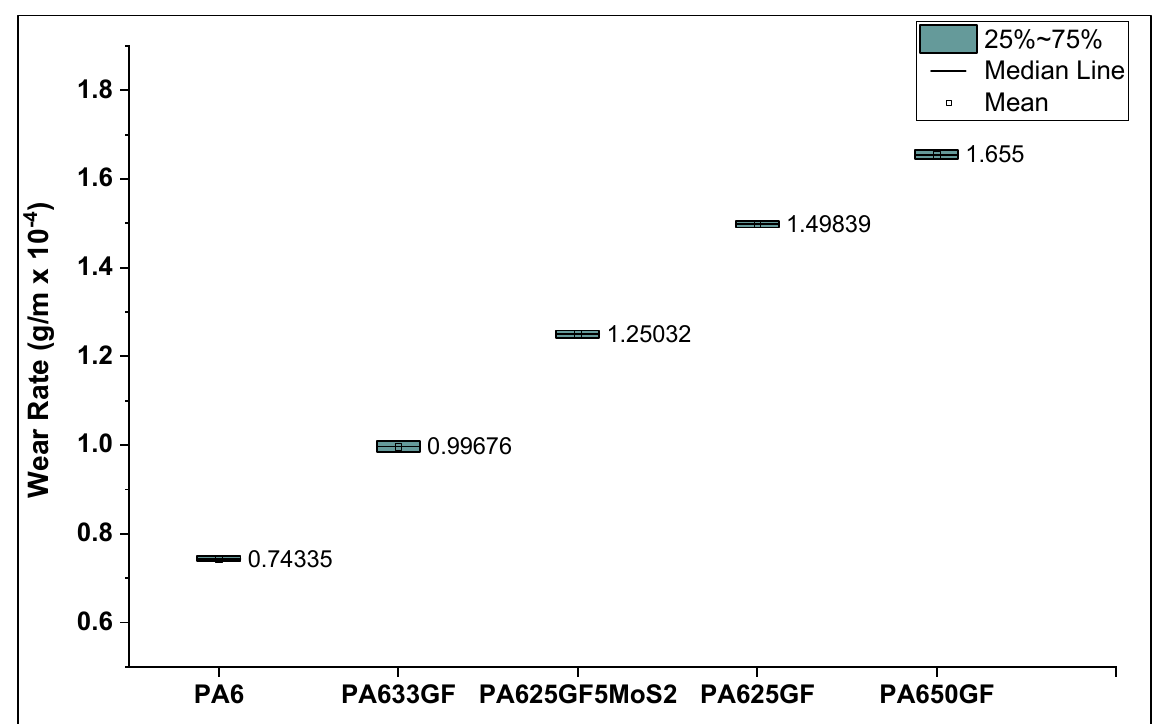
Figure 9. Wear rate of PA6 reinforced with glass fibres at varied fibre volume fractions .